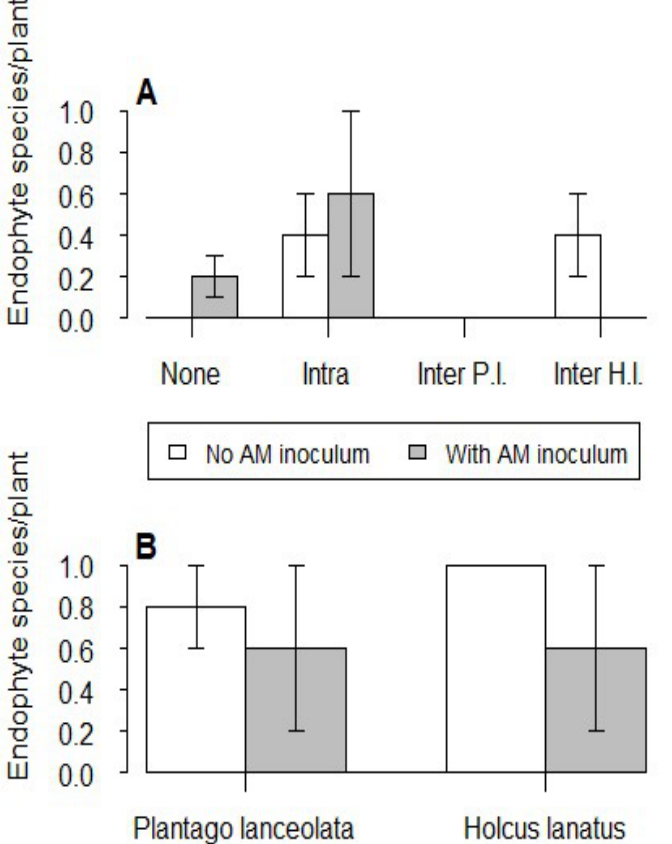
Figure 3. ( A ): Mean number of endophyte fungal species per plant in I. glandulifera when grown singly (None), experiencing intraspecific competition (Intra), or experiencing interspecific competition with P. lanceolata (Inter P.l.) or H. lanatus (Inter H.l.). ( B ): Mean number of endophyte species per plant in P. lanceolata and H. lanatus when grown in competition with I. glandulifera. Vertical bars represent ± one standard error.